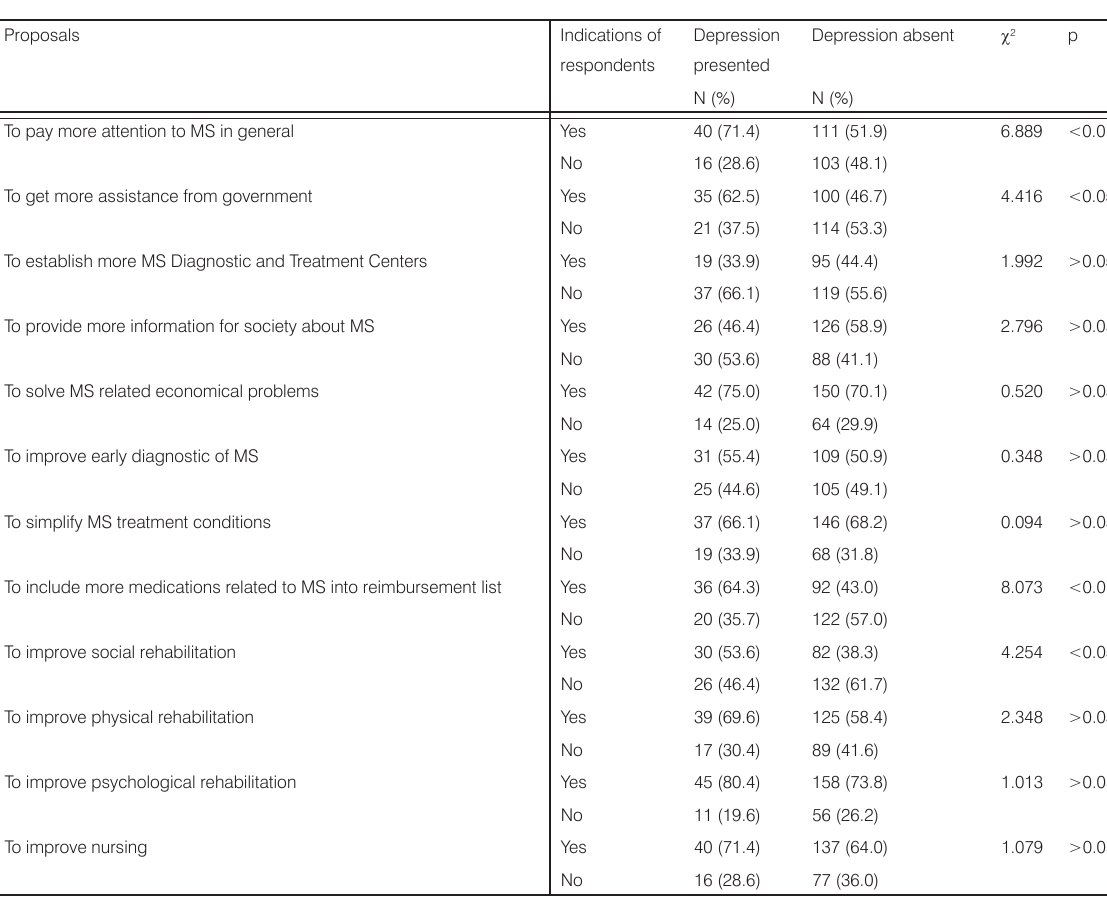
Table 4. Review of proposals evaluation